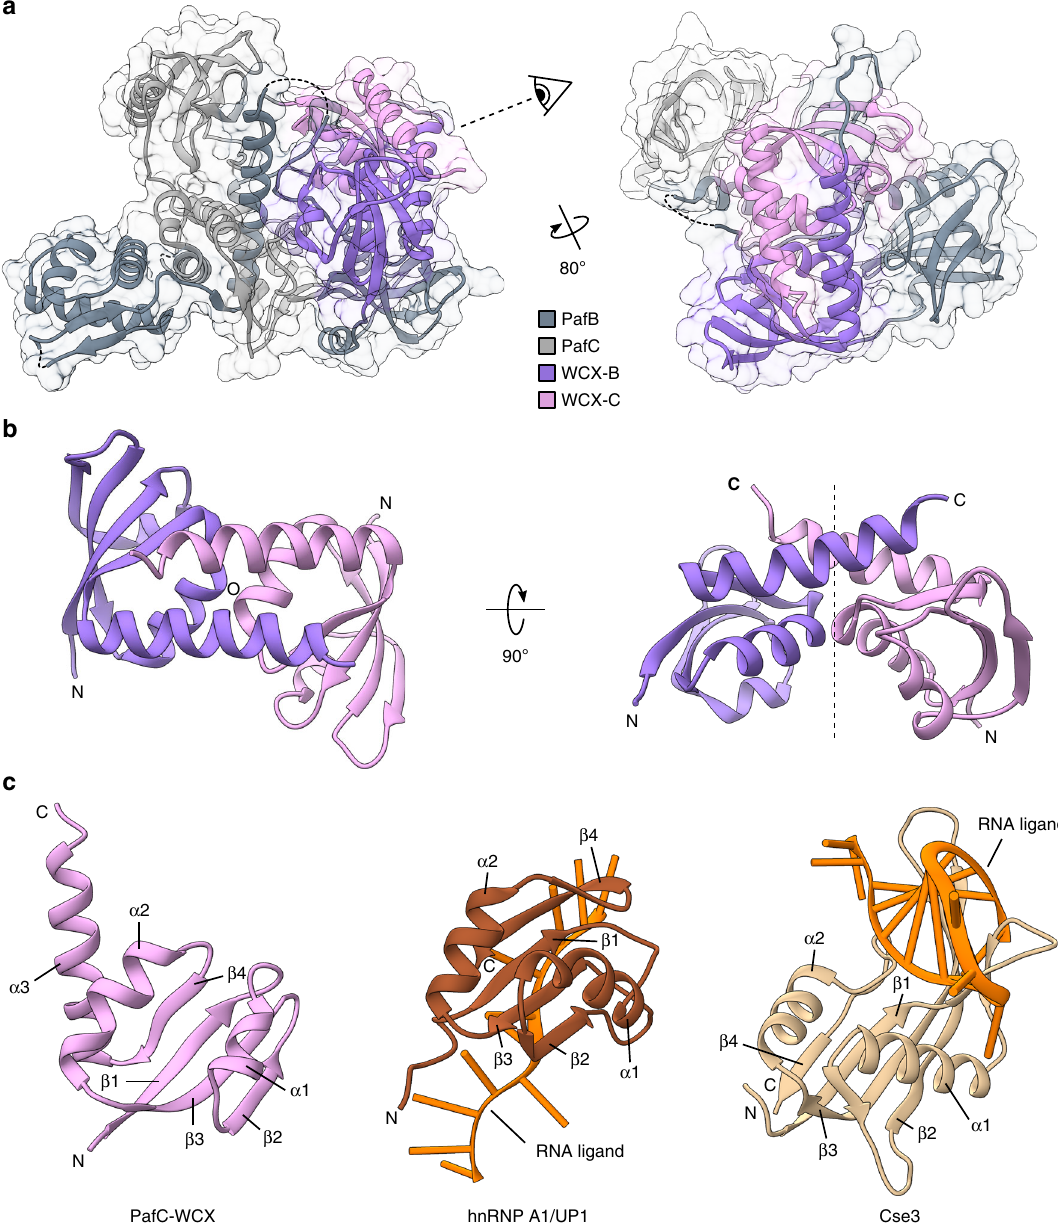
Fig. 3 The C-terminal extension (WCX) domains of PafB and PafC contain a ferredoxin-like fold. a The WCX domains of PafB (WCX-B, lilac) and PafC (WCX-C, pink) contact each other in the crystal structure. Dashed lines bridge gaps in the model. b WCX-B and WCX-C exhibit a two-fold rotational symmetry axis (circle and dashed line). c The WCX domains (left; shown for PafC; residues 585 – 664) contain a ferredoxin-like fold with an additional C- terminal α -helix ( α 3). Very versatile and present in proteins with highly diverse functions, the ferredoxin-like fold is also found in many RNA-binding proteins such as human hnRNP A1 (also known as UP1; middle; brown; PDB 6DCL; residues 7 – 89 shown) or the C-terminal domain of CRISPR-Cas protein Cse3 (right; beige; PDB 2Y8W; residues 90 – 211 shown). RNA ligands are colored in